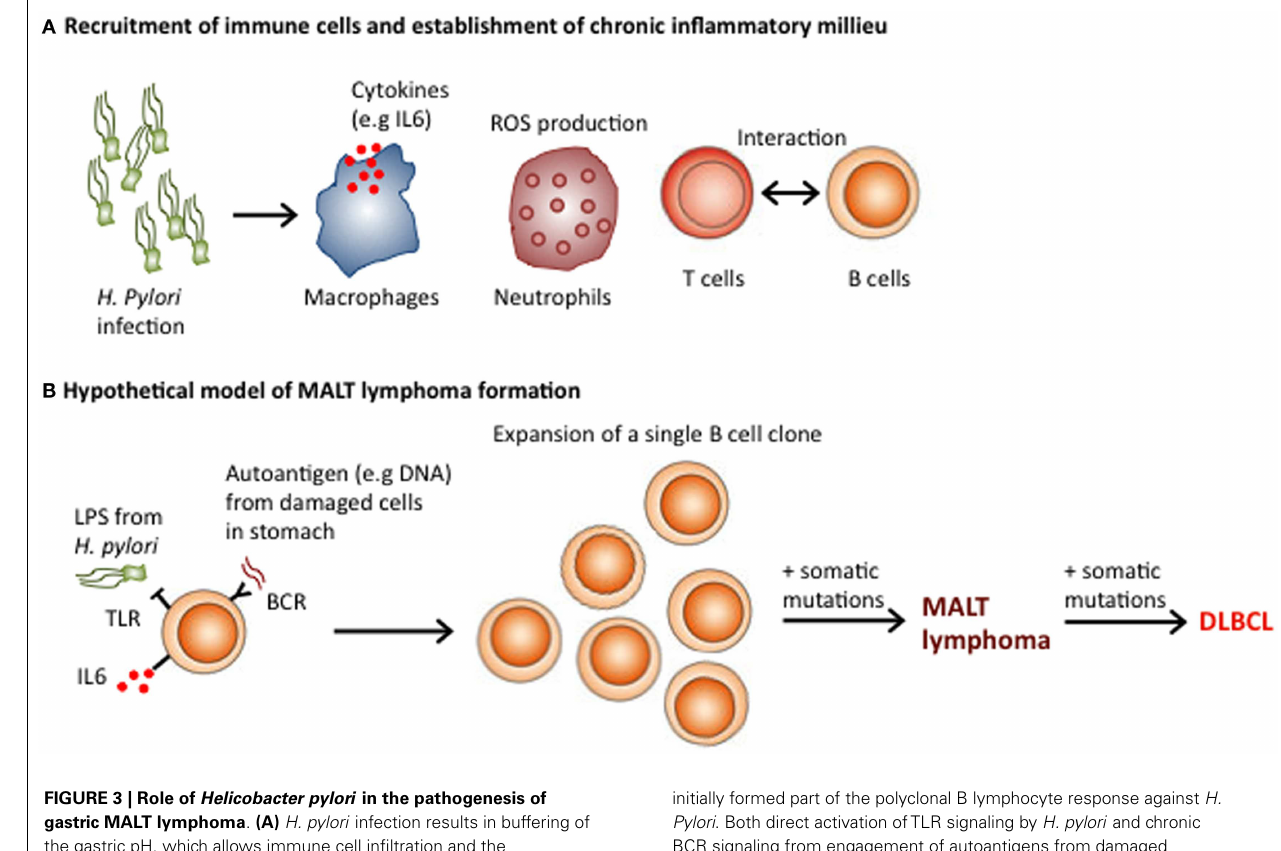
initially formed part of the polyclonal B lymphocyte response against H. Pylori . Both direct activation ofTLR signaling by H. pylori and chronic BCR signaling from engagement of autoantigens from damaged stomach cells and the B cell receptor, in addition toT cell-B cell co-stimulation could be involved in the expansion of the single neoplastic B cell clone. Acquisition of additional genomic lesions could transform MALT lymphomas into more aggressive